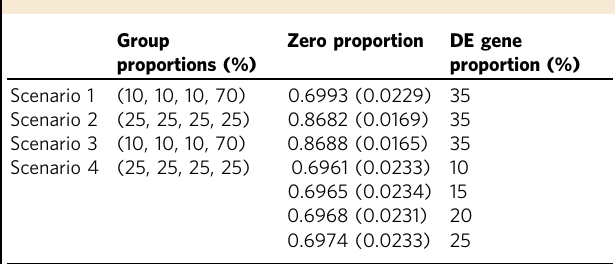
Table 1 Settings in simulation